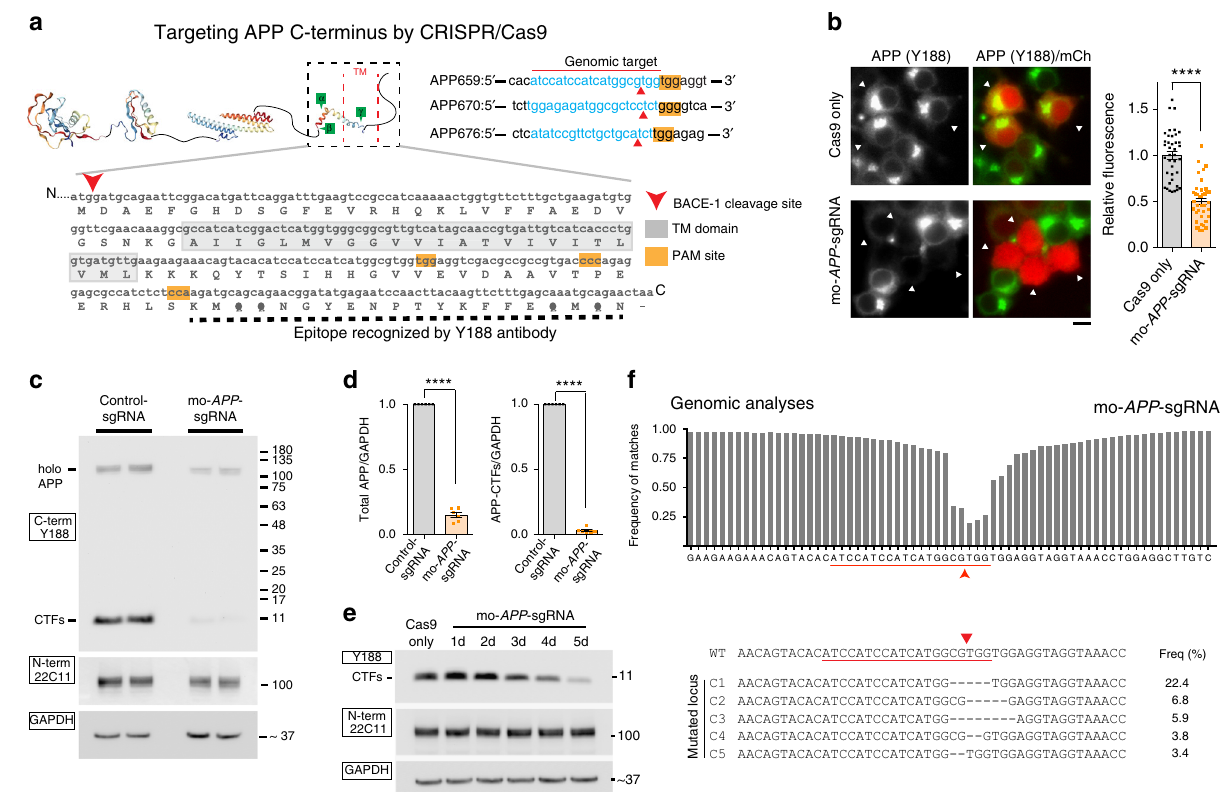
Fig. 1 Manipulation of the amyloid pathway by CRISPR/Cas9 editing. a Schematic and C-terminal sequence of mouse APP showing PAM sites (yellow) and genomic targets for the three APP -sgRNAs ( APP 659-sgRNA used henceforth and referred to as ‘ APP -sgRNA ’ – see text). Note that the C-terminal antibody Y188 recognizes the last 20 aa. of APP (black dashed line). b Neuro2a cells were transfected with mo- APP -sgRNA and Cas9 (or Cas9 only), and immunostained with the Y188 antibody (after 5 days; mCherry labels transfected cells). Note decreased APP (Y188) fl uorescence, indicating APP editing (quanti fi ed on right, mean ± SEM of 39 cells from two independent experiments per condition). Scale bar 10 μ m. c , d Neuro2a cells were transduced by lentiviral vectors carrying mo- APP -sgRNA and Cas9 (or non-targeting control-sgRNA/Cas9 as control) and immunoblotted with Y188 and 22C11 antibodies (latter recognizes APP N-terminus). A gamma secretase inhibitor (GSI) was added to allow detection of accumulated APP CTF ’ s (see methods, GAPDH used as loading controls). Note attenuated signal with the Y188 antibody in mo- APP -sgRNA treated samples, but no change in 22C11 signal. Blots quanti fi ed in d , mean ± SEM of six independent experiments. e Time course of APP-editing in neuro2a cells. Cells were transfected with a vector carrying mo- APP -sgRNA and Cas9, and APP-CTFs were analyzed by Western blotting (in the presence of GSI). f Deep sequencing of APP C-terminus in neuro2a cells. Top: Frequency of base-pair matches between CRISPR-edited and WT mouse sequence. Red underline marks the sgRNA target sequence and arrowhead denotes predicted cut-site. Note extensive mismatch around predicted cut-site, indicating robust editing. Bottom: Major mutated APP loci resulting from sgRNA-editing, and their frequencies. For all panels, signi fi cance determined with two-tailed t -test, **** p < 0.0001. Source data are